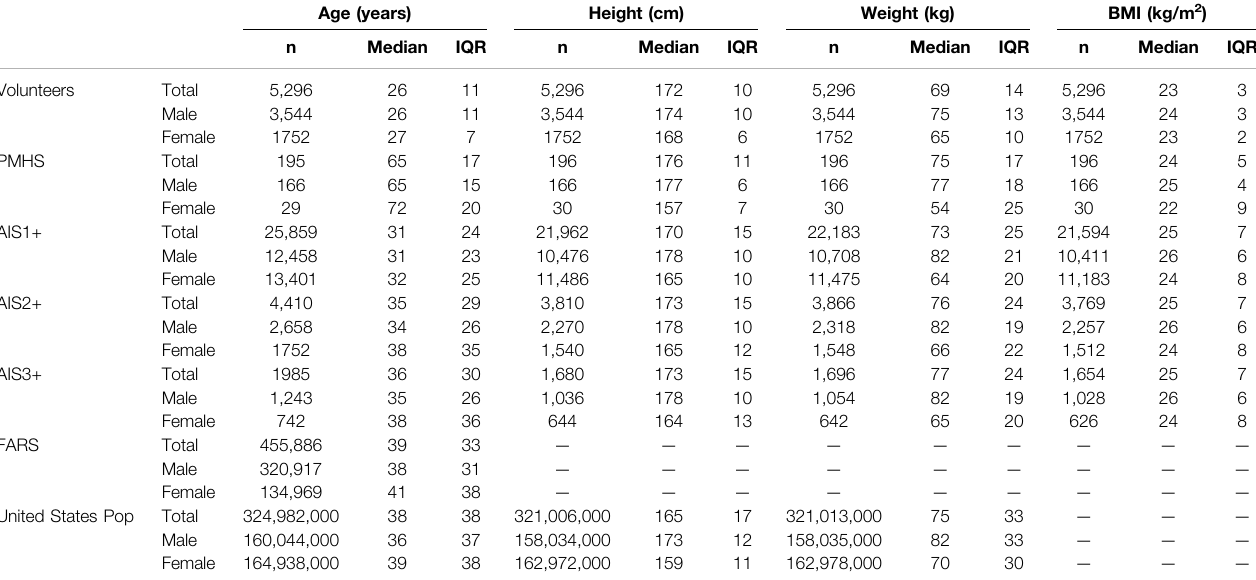
TABLE 2| Samplesize(n), median, andinterquartile range(IQR) oftheage,height, weight,andBMI dataforthevolunteer tests,PMHStests, AIS1+,AIS2+,andAIS3+ from the NASS data, FARS data, and the United States population. Age (years) Height